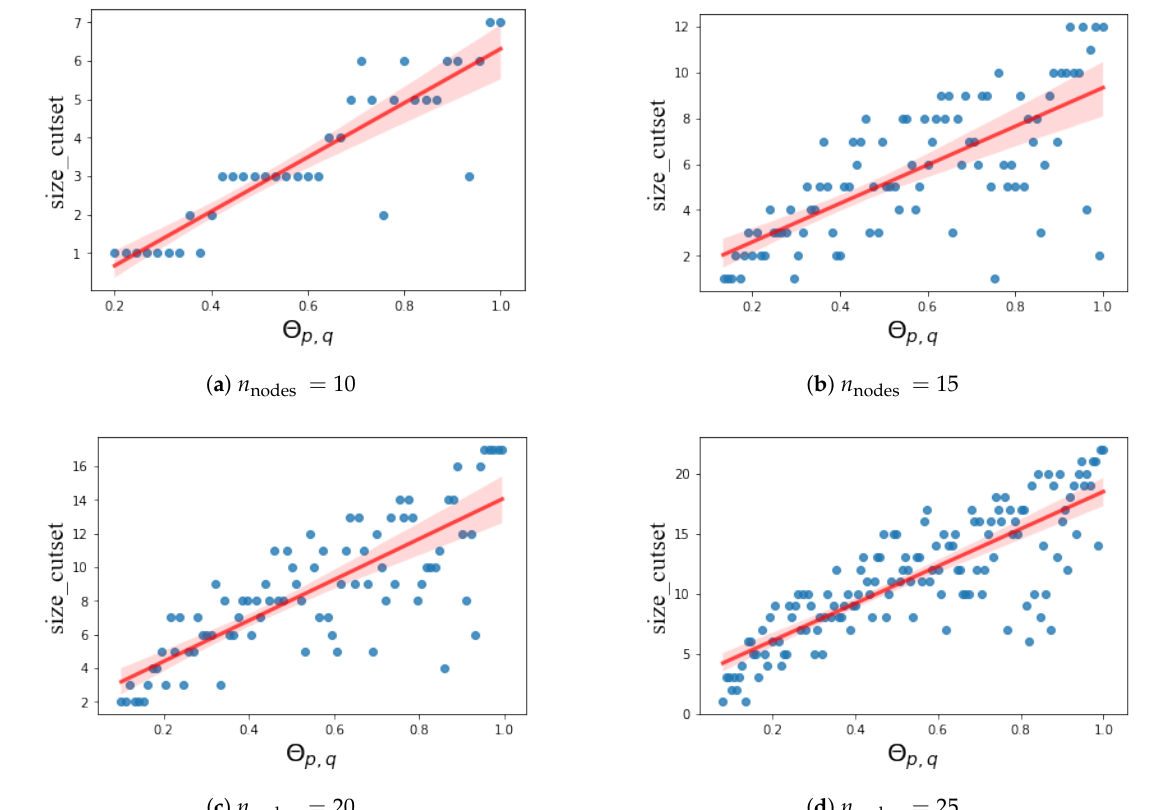
Figure 2. The change trend of the loop cutset size with the parameter Θ p , q . (Here n nodes is the number of the